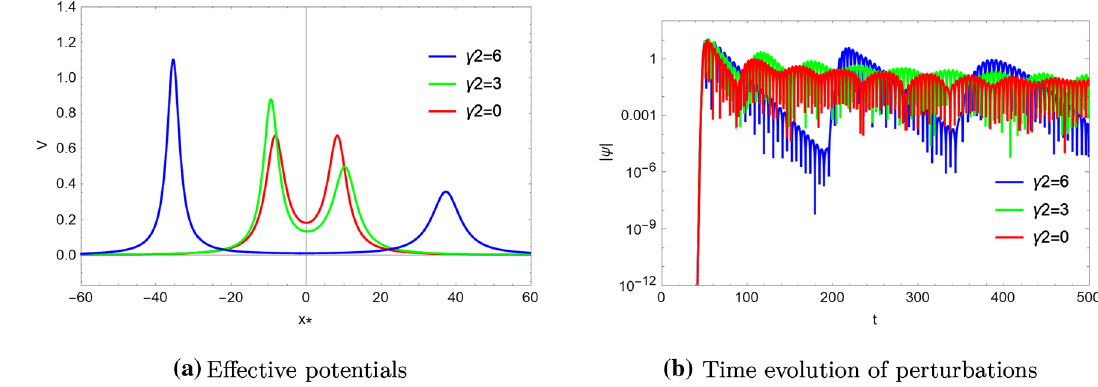
Fig. 2 The effective potentials and the corresponding time evolution profiles with different γ 2 . We set q = 1 . 65 ,γ 1 = − 10 , l = 2 , Q = 1